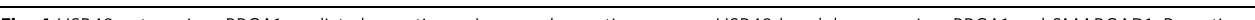
Fig. 4 USP48 antagonizes BRCA1-mediated resection. a Increased resection seen on USP48 knockdown requires BRCA1 and SMARCAD1. Resection lengths were measured in HeLa cells depleted as indicated. Cells were treated with 10 mM BrdU for 24 h with addition of 10 µ M Olaparib for the fi nal 16 h. Cells were lysed and DNA fi bres spread before staining for BrdU-positive single-stranded DNA resection tracks. n = 190 tracks for each condition. Bars indicate median, also shown numerically in brackets. *** p < 0.005 Mann – Whitney test. b Western blottings to demonstrate protein expression levels in HeLa cells following siRNA as indicated. c Rad51 foci formation in S-phase (EdU positive) HeLa cells depleted as indicated. Cells were fi xed at 2 h post 5 Gy IR. Scale bars = 10 µ m (see Supplementary Fig. 6a, b for quanti fi cation). d Suppressive impact of USP48 Iso2 overexpression on resection lengths can be rescued by co-expression of an uncleavable H2A-Ub fusion. Resection lengths were measured in untransfected HeLa cells or those transfected with USP48 Iso2 and expressing either H2A or H2A-Ub fusion (KR2 denotes that lysines 13/15, 118/119, and 125/127/129 were mutated to arginines). Cells were prepared as in a and 210 tracks were measured for each condition. Bars indicate median, also shown numerically in brackets. *** p < 0.005, NS = nonsigni fi cant, Mann – Whitney test. e USP48 restricts positioning of 53BP1 in damage foci. Images of BRCA1 and 53BP1 in cells treated with control